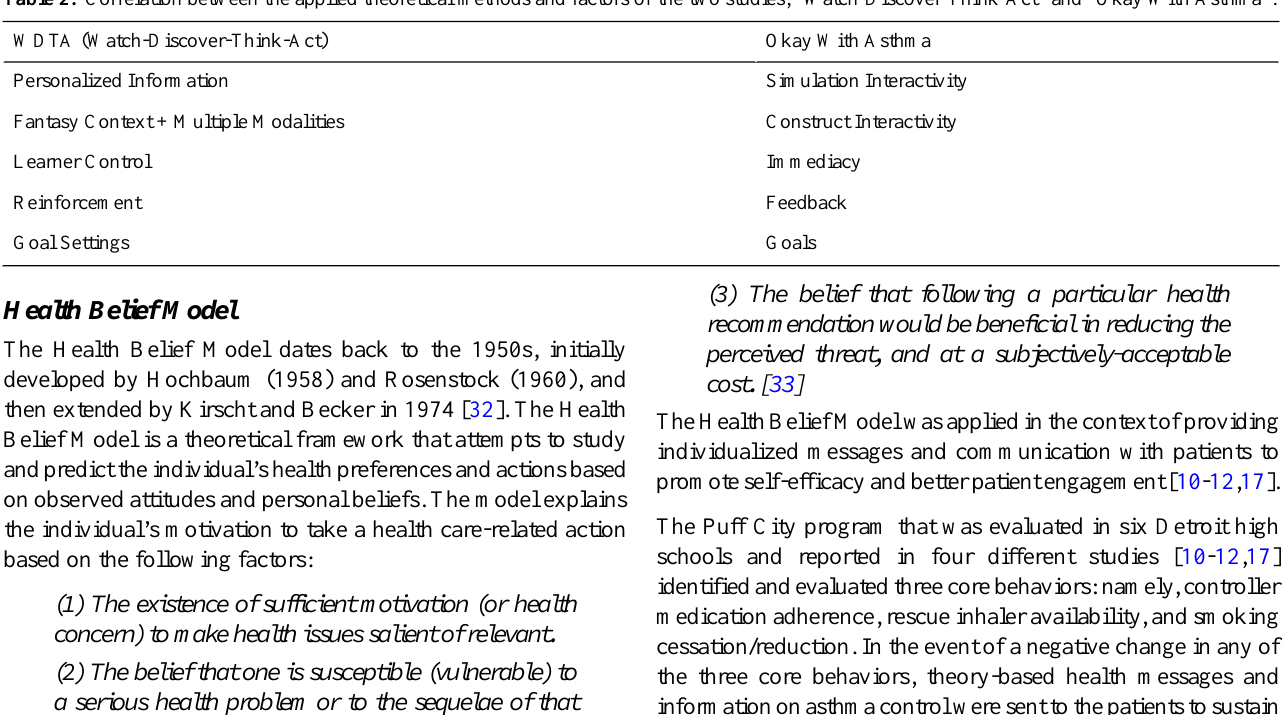
Table 2. Correlation between the applied theoretical methods and factors of the two studies, “Watch-Discover-Think-Act” and “Okay With Asthma”.